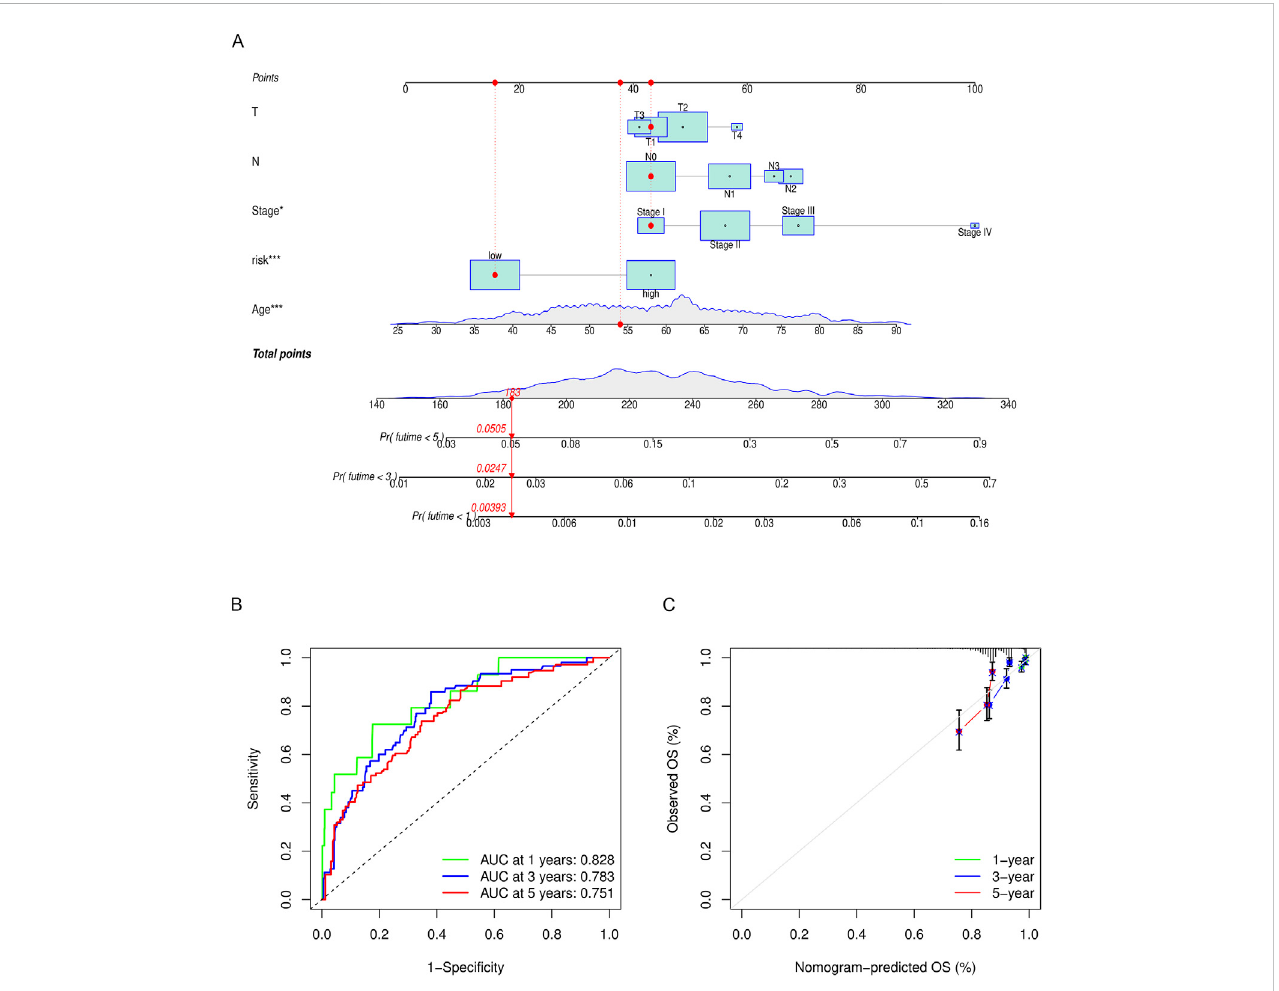
FIGURE 11 (A) Nomogram to predict the overall survival of breast cancer patients. The overall survival probability is calculated by taking the sum of the risk points, according to the T stage, N stage, clinical stage, risk group, and age. For each parameter, its risk point can be determined by drawing a vertical line straight up from the variables ’ value to the “ Points ” axis. In order to determine the probability of surviving less than 5 years, a vertical line is drawn intersecting the “ Total points ” with the “ Pr (futime < 5) ” line. (B) 1-, 3-, and 5-year ROC curves of the nomogram. (C) 1-, 3-, and 5-year calibration curves of the